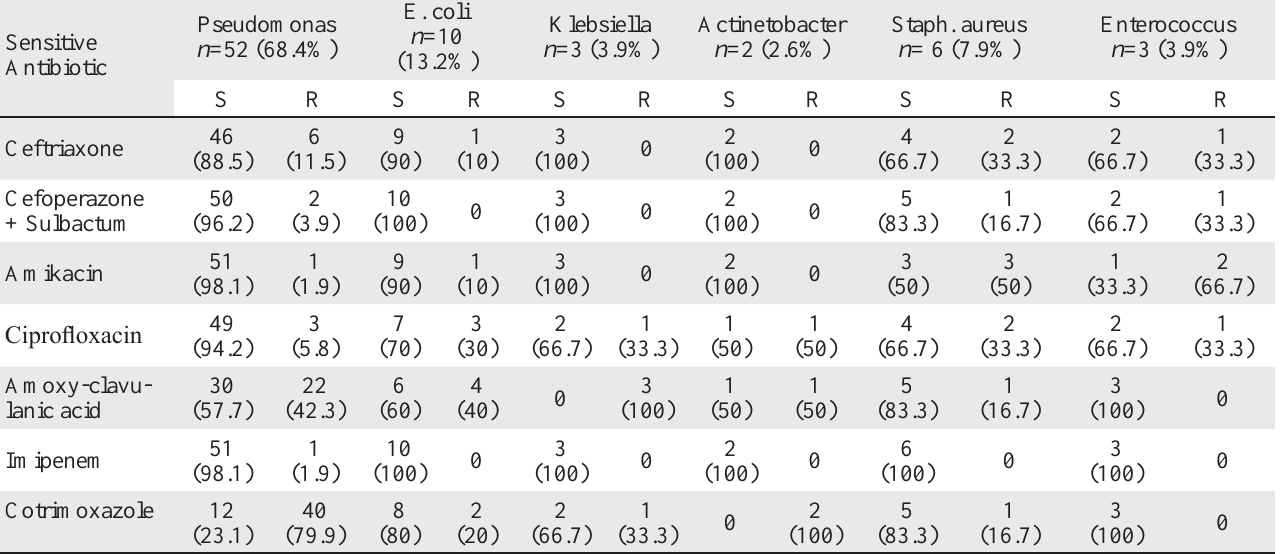
Table 2 : Sensitivity and resistance of common isolated bacteria to various antibiotics. Sensitive